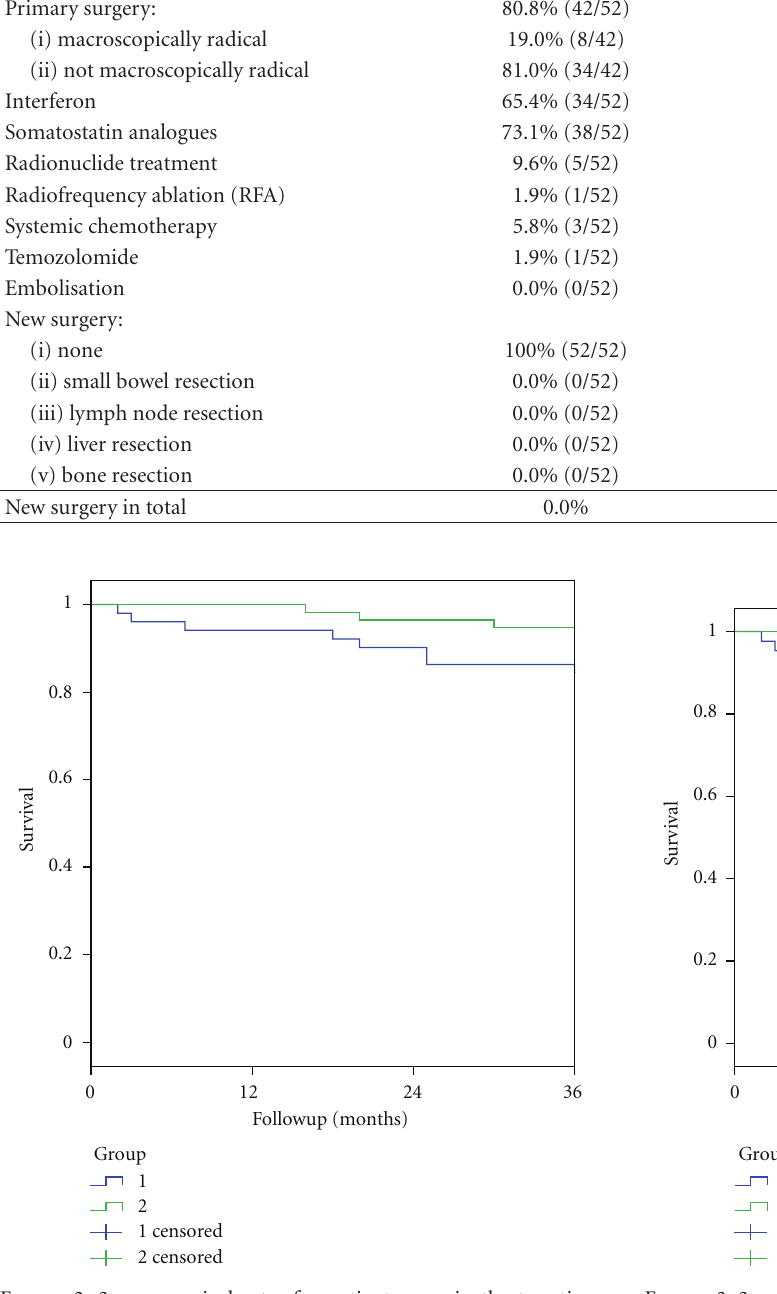
Figure 3: 3-year survival rates for patients without radical surgery seen in the two time periods from January 1994 to June 2003 (Group 1) and from July 2003 to December 2011 (Group